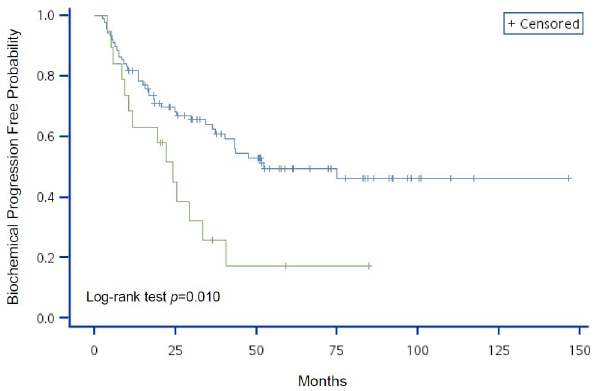
Figure 4. Kaplan-Meier analysis of BCP-free probability for advanced prostate cancer patients by risk group using pathologic fracture. The blue line represents patients without pathologic fracture and the green line represents patients with pathologic fracture. P -value of Log-rank test=0.010.